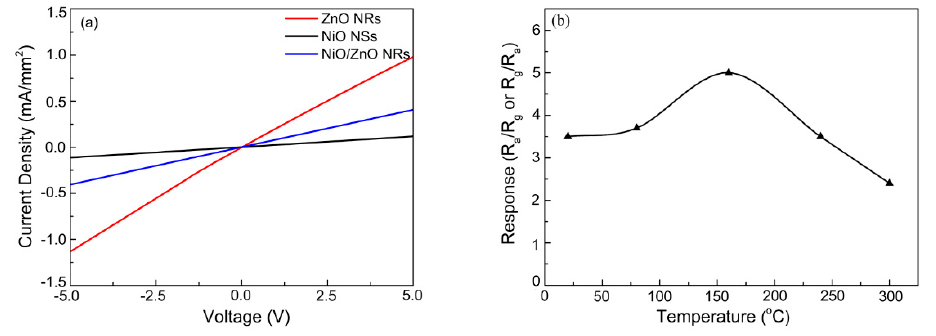
Figure 6. ( a ) Current density-voltage characteristics at 160 °C and ( b ) responses of NiO/ZnO-heterostructures-based sensor to 1 ppm of H 2 S at different operating temperatures.